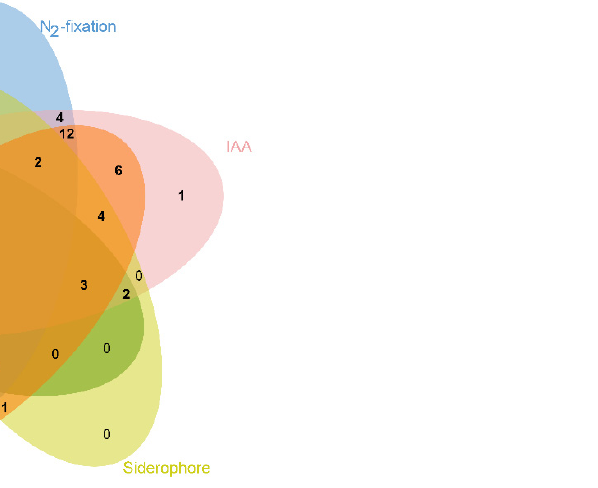
Figure 3. Venn diagram showing the distribution of seed-colonizing endophytic bacteria with different PGP traits isolated from DXWR seeds.